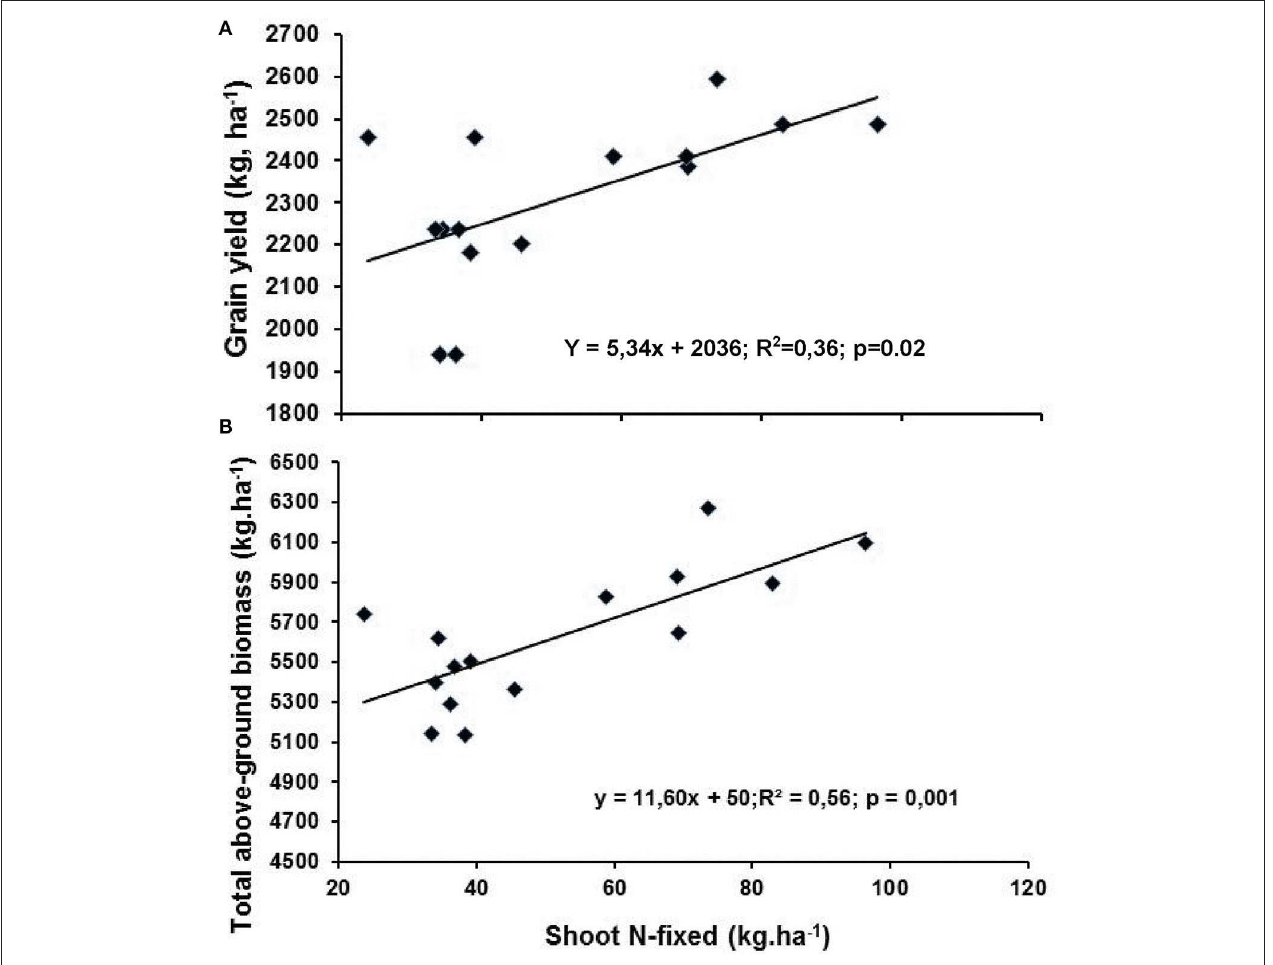
FIGURE 6 | Relationship between (A) average amount of N-fixed by all preceding legumes vs. maize grain yield from zero-N plots of the five grain legumes, and (B) average amount of N-fixed by all preceding legume and maize shoot DM from zero-N plots of the five grain legumes at Nelspruit, Mpumalanga Province, in the 2012/2013